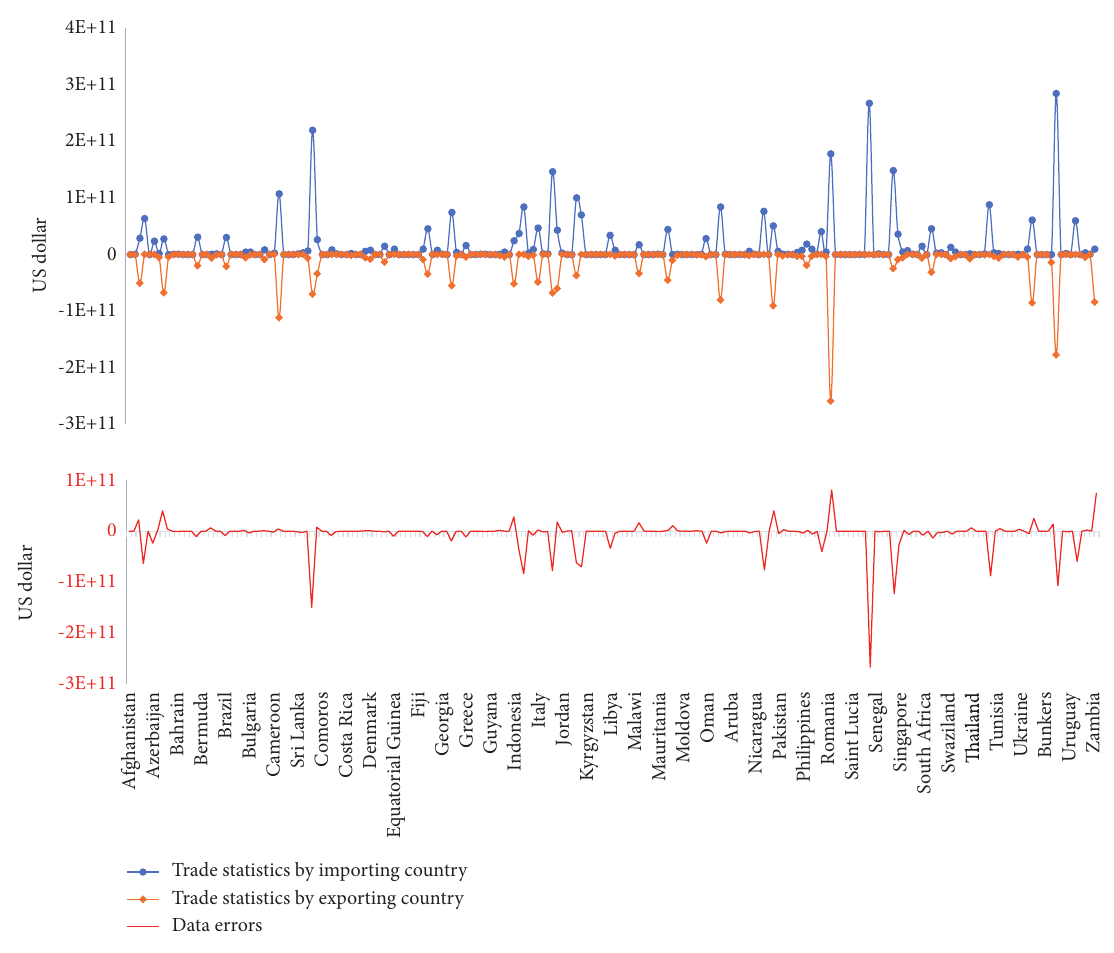
Figure 3: Data uncertainty example of oil export in 2013.